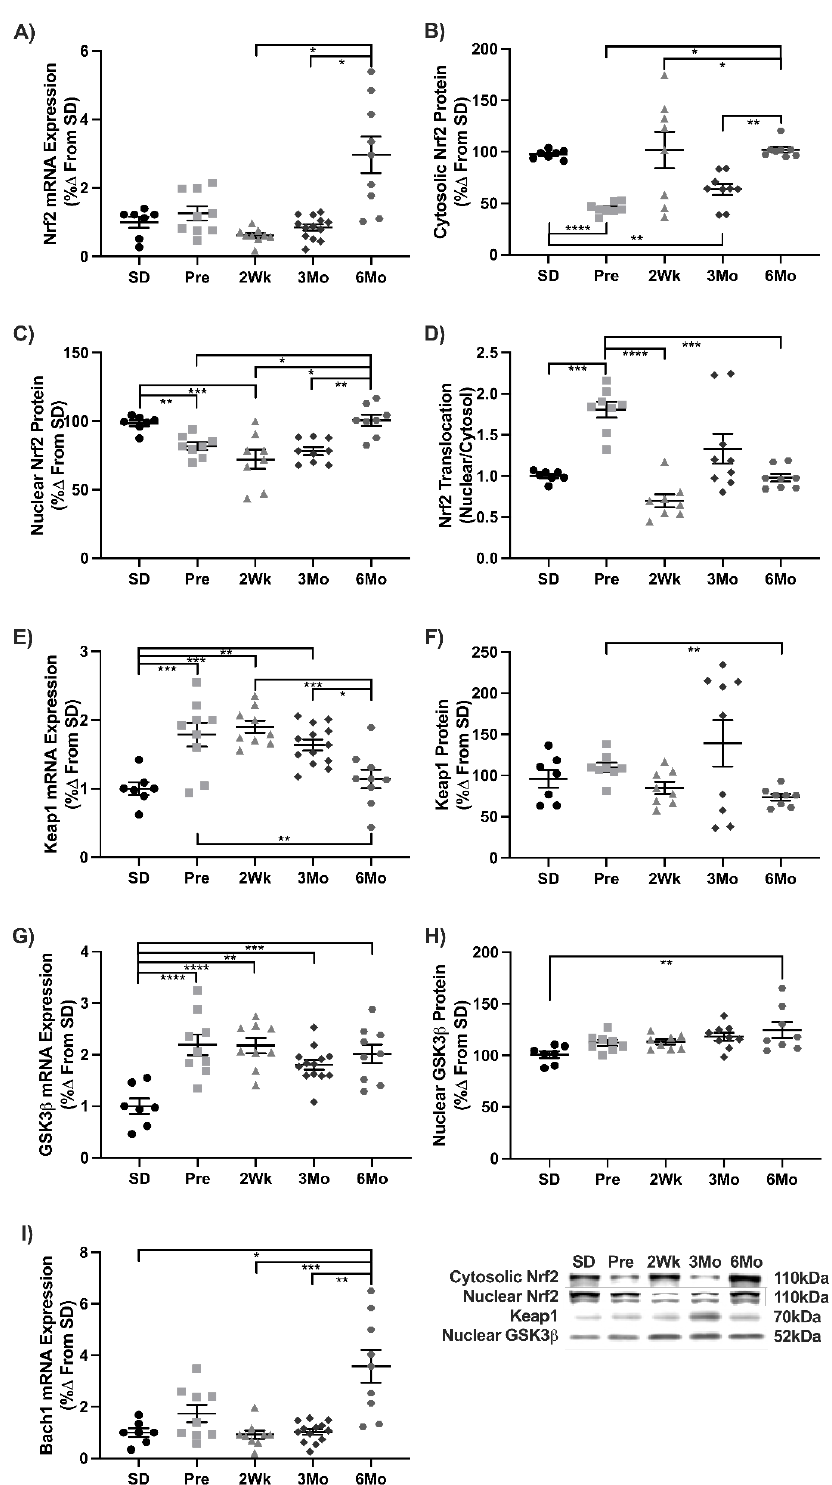
Figure 3. Nrf2 signaling during the progression of T2DM. Mean ± SEM values of ( A ) Nrf2 mRNA, ( B ) cytosolic Nrf2 protein, ( C ) nuclear Nrf2 protein, ( D ) Nrf2 translocation, ( E ) Keap1 mRNA, ( F ) Keap1 protein, ( G ) GSK3 β mRNA, ( H ) nuclear GSK3 β protein, and ( I ) Bach1 mRNA in Sprague- Dawley (SD; n = 7), pre-diabetic UCD-T2DM (Pre; n = 9), 2-week diabetic UCD (2Wk; n = 9),